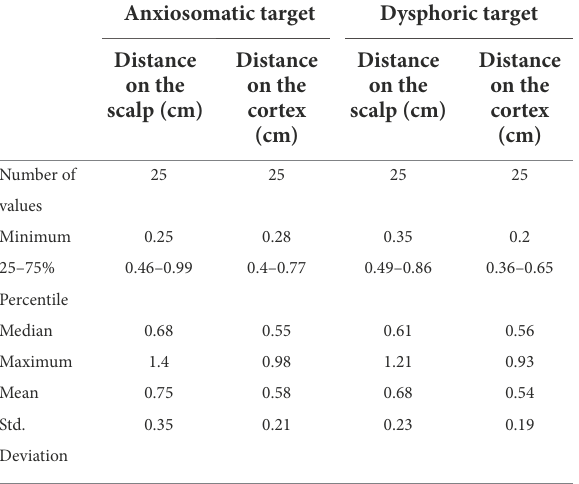
TABLE 2 The distance (cm) between the personalized and landmark- based targets in the validation